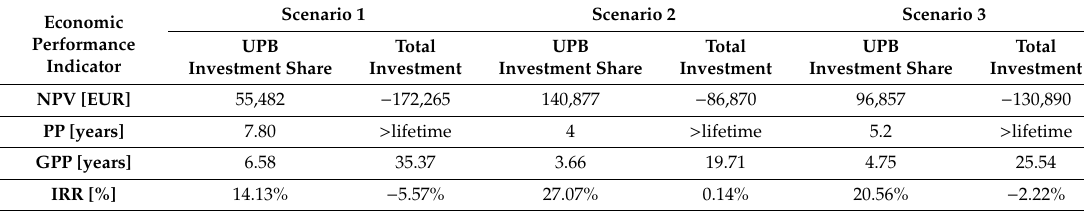
Table 4. Technical-economic analysis